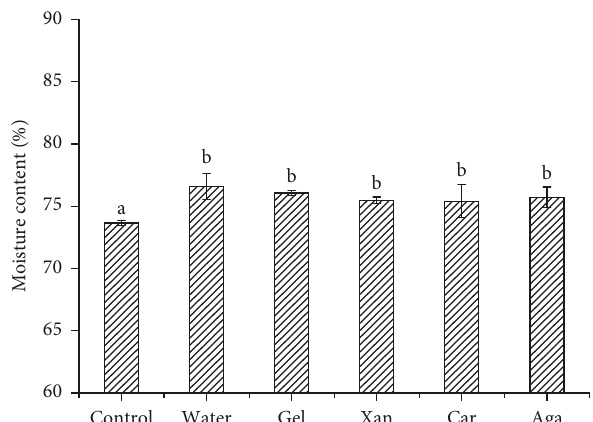
Figure 2: Effects of different hydrocolloids in intramuscular in- jection on the moisture content of porcine meat.